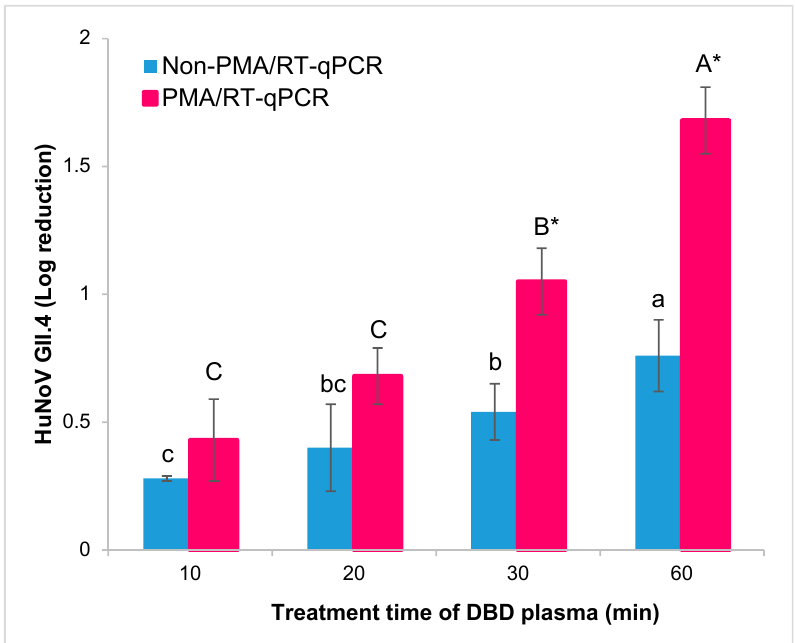
Figure 2. The capital letters (A–C) represent propidium monoazide (PMA) pretreated HuNoV reduction. The lowercase letters (a–c) represent non-PMA pretreated HuNoV reduction. Within each DBD plasma treatment time, log reduction means with different letters (a–c or A–C) differ